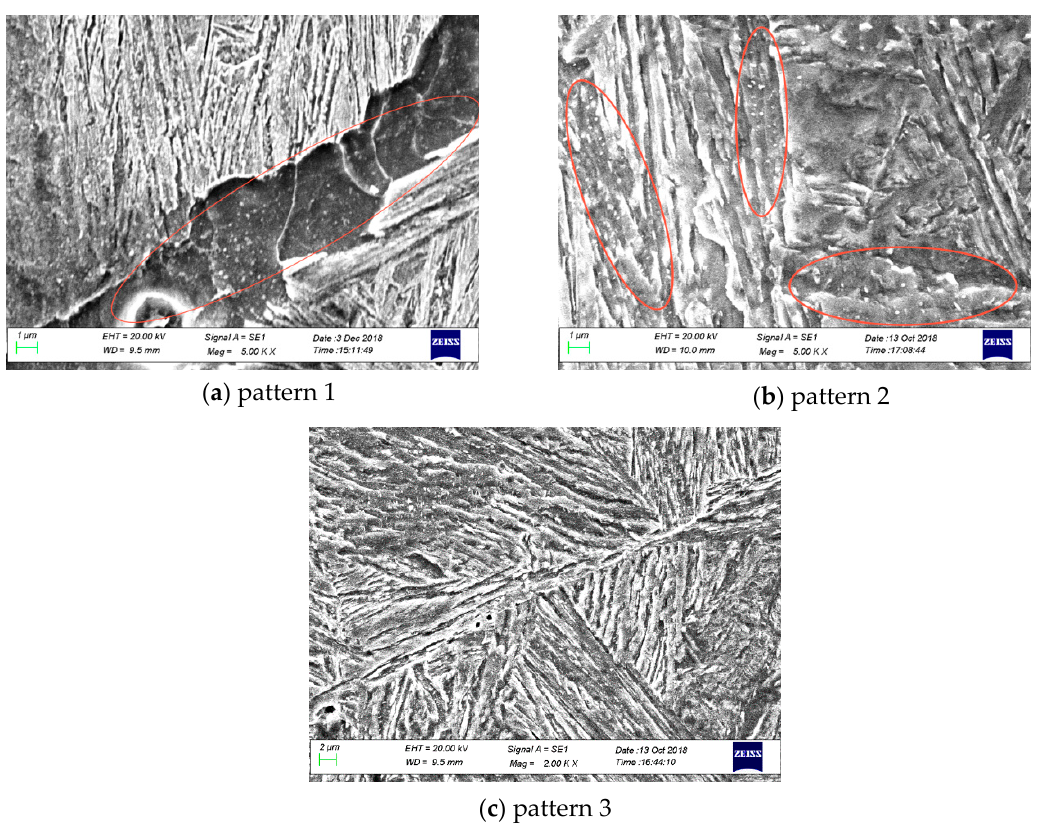
Figure 13. Etched microstructures at 800 °C observed by SEM under different thermal schedules.